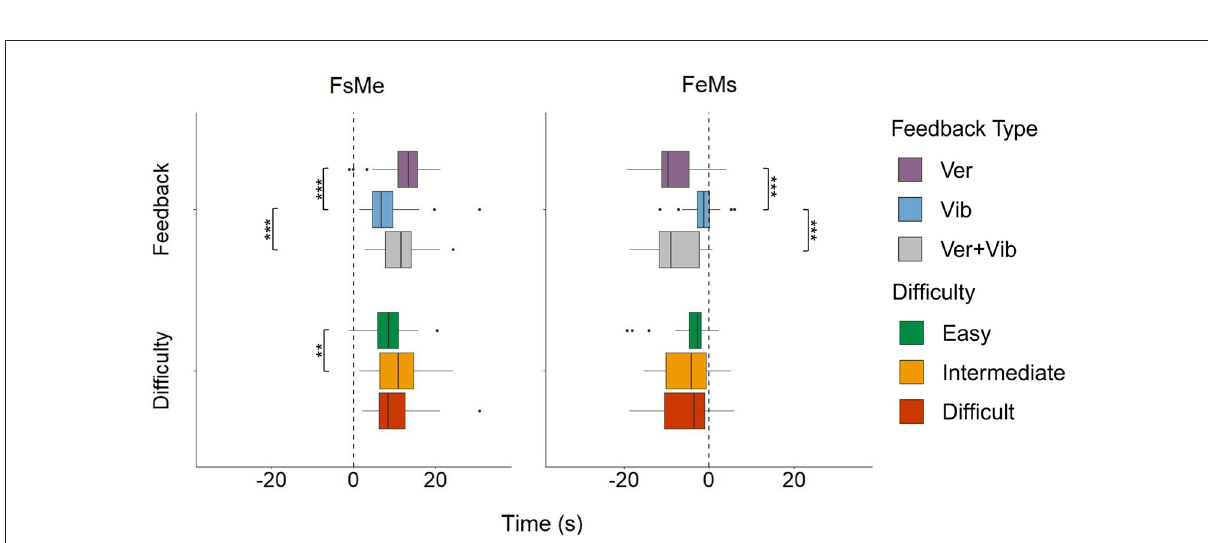
FIGURE7 FsMe and FeMs by feedback type and pose difficulty level. “**” and “***” indicates statistically significant pairwise comparisons for which p < 0.01 and p < 0.001,